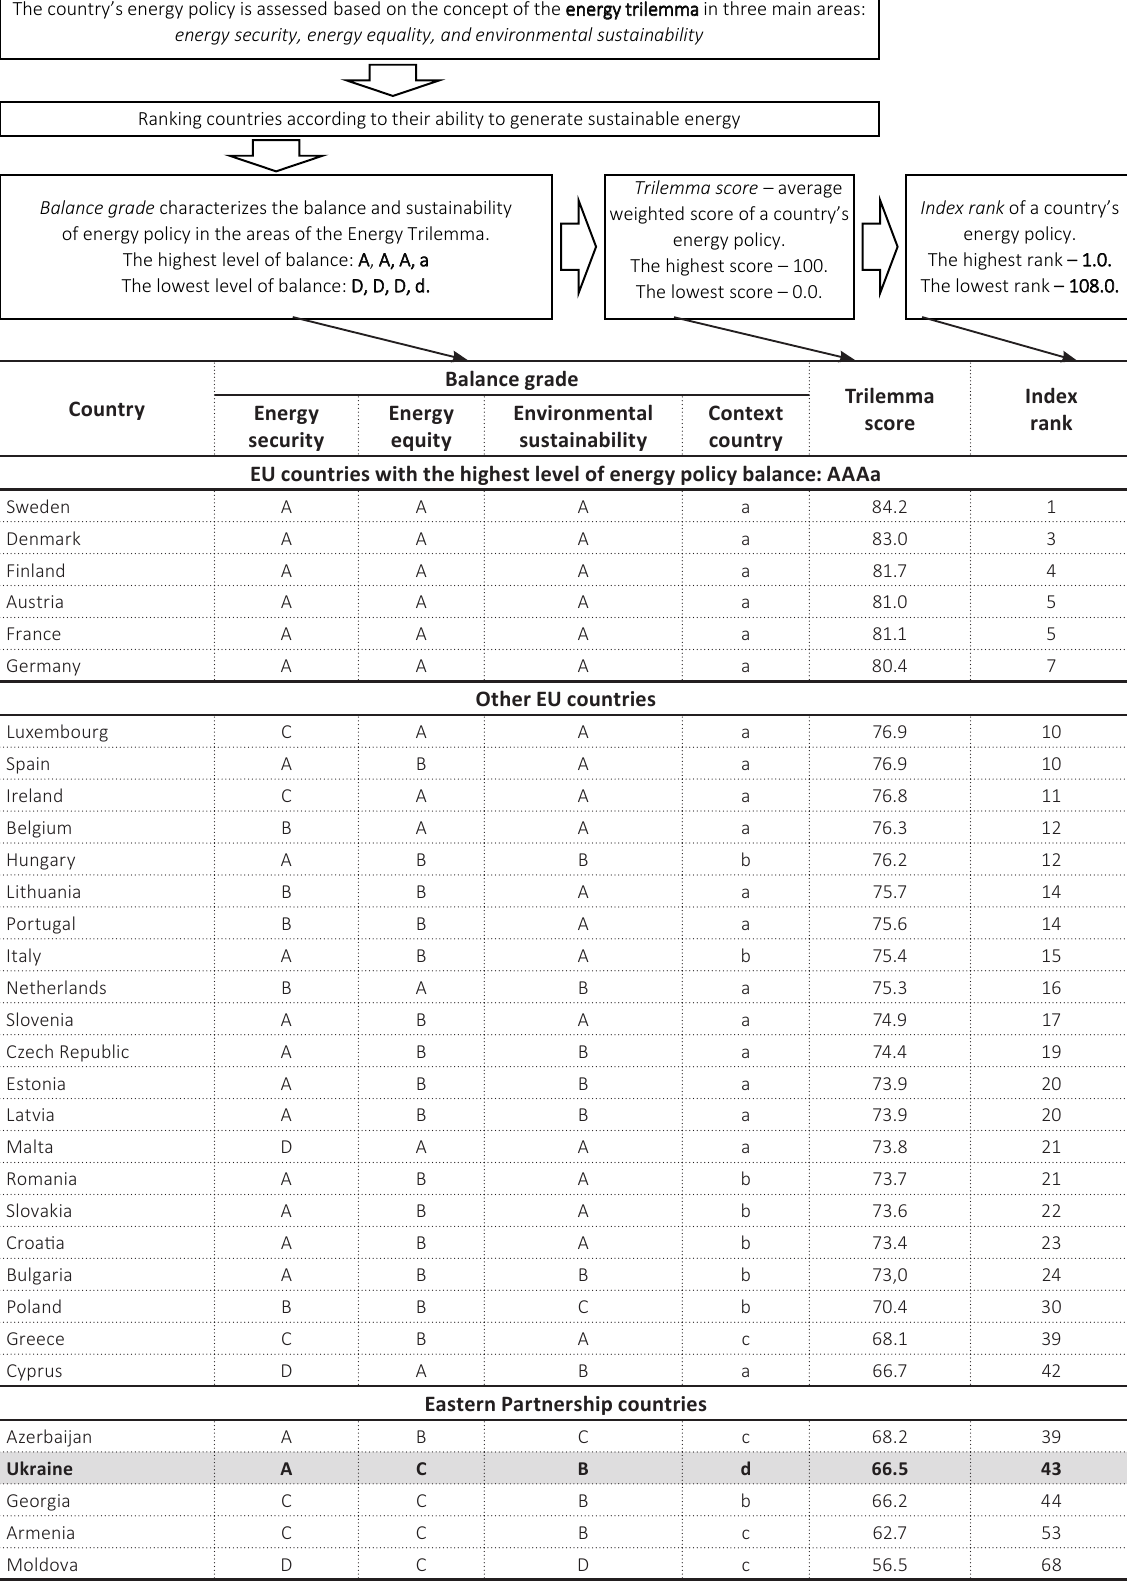
Figure 1. Energy Trilemma Index of the EU and Eastern Partnership